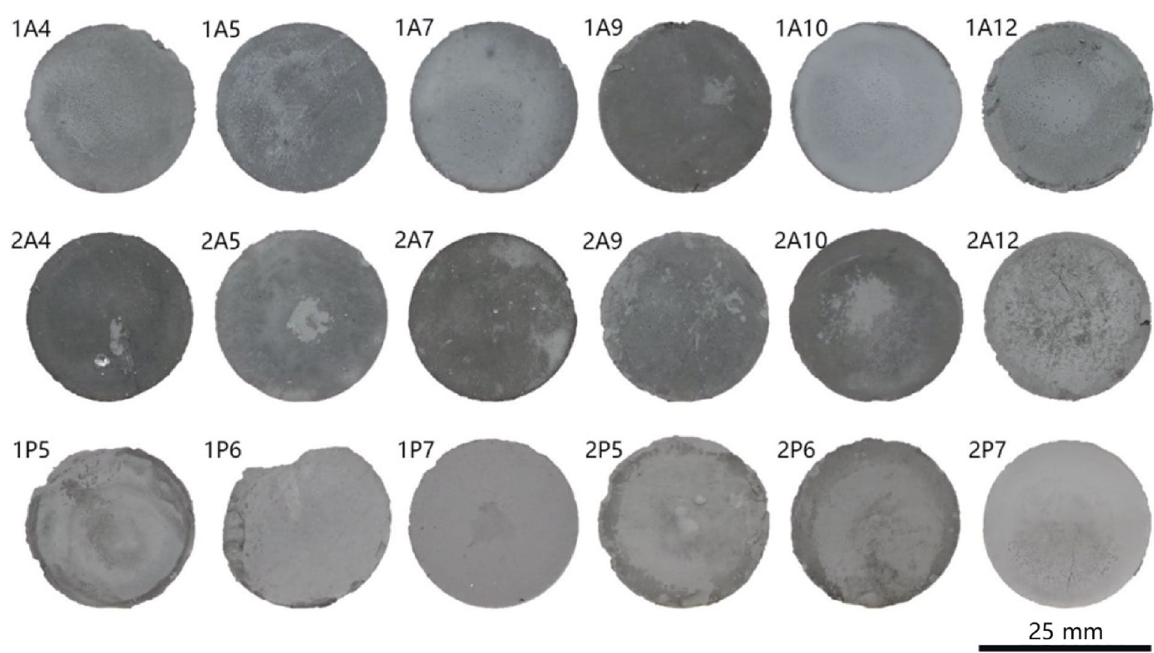
shape if compared with other samples (Fig. 4).